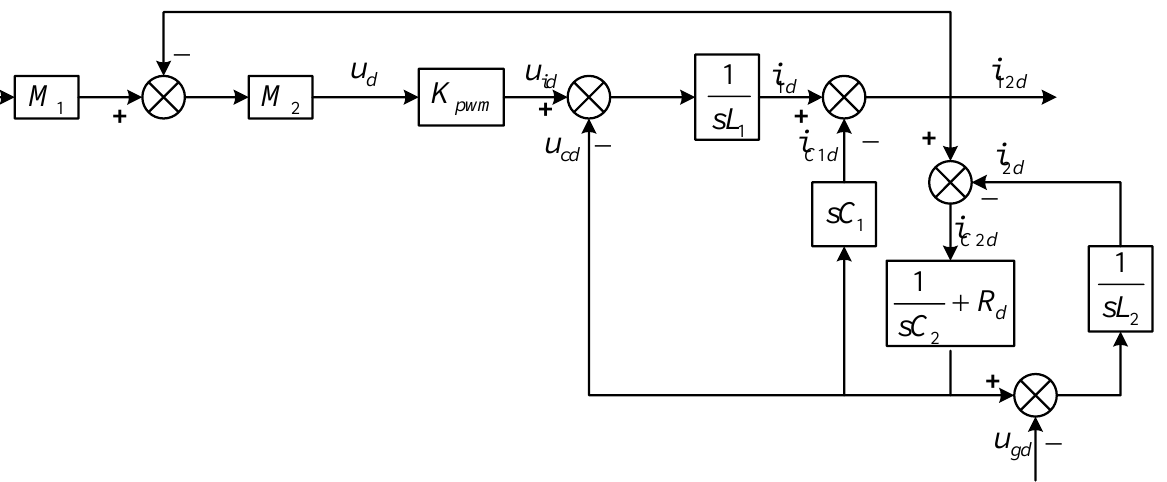
Figure 4. D -axis structure diagram of split capacitor control system. Figure 4. D- axis structure diagram of split capacitor control system.